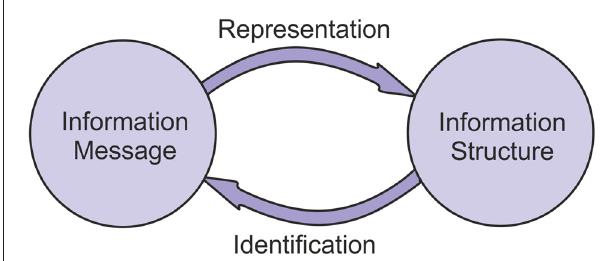
FIGURE 2 | The reciprocal relationship between information structures and messages. Information structures represent information messages, and information messages can be identified from information